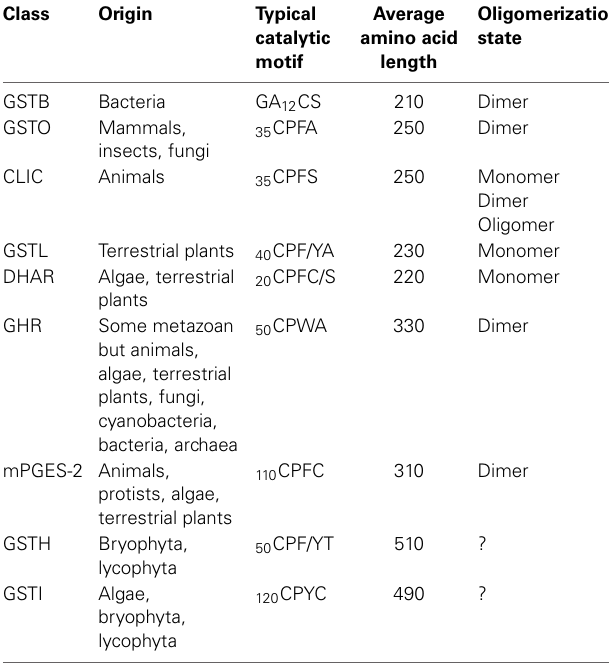
Table 2 | Characteristics and distribution of